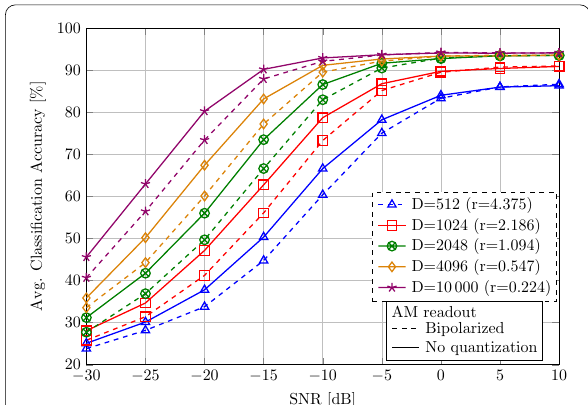
Fig. 12 Classification accuracy (%) in 5-class gesture recognition on 64-channel EMG data. The transmitted HD vector is interfered with